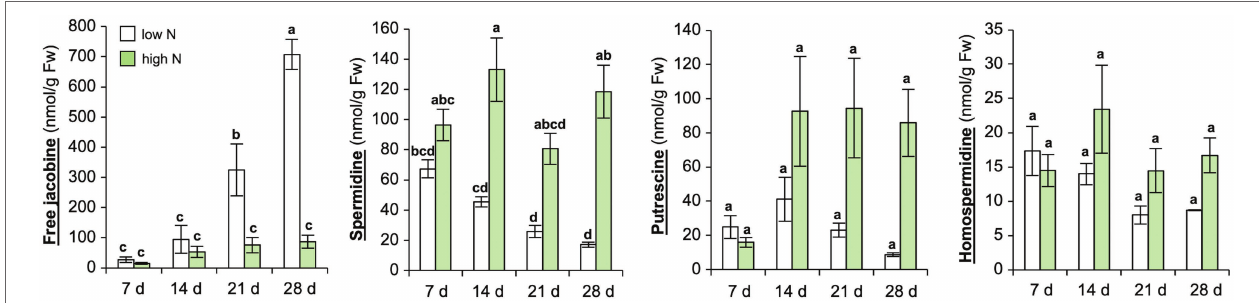
FIGURE 2 | Nitrogen starvation yields strong increases of jacobine in Crassocephalum crepidioides leaves. C.c. Ile-Ife plants, grown in low nutrient pond soil, were fertilized with ammonium nitrate either at a low (150 mg N/kg DW) or at a high dose (500 mg N/kg DW). The nitrate treatment started at 7 weeks post germination and was performed two times, in 2-week intervals. Leaf samples were taken from 3 to 4 plants per treatment group at the indicated time-points after the last ammonium nitrate addition and concentrations of free jacobine, spermidine, putrescine, and homospermidine were measured by HPLC. The columns and bars represent the average and standard error of 3–4 independent biological replicates. Statistically significant difference of results between time-points and N levels at p ≤ 0.05 is indicated with different letters and was determined with one-way ANOVA followed by Tukey’s HSD test (jacobine: ANOVA F 7,23 = 28.356, p < 0.0001; spermidine: ANOVA F 7,20 = 12.029, p < 0.0001; putrescine: ANOVA F 7,20 = 3.880, p = 0.008; homospermidine: ANOVA F 7,20 = 1.984, p =